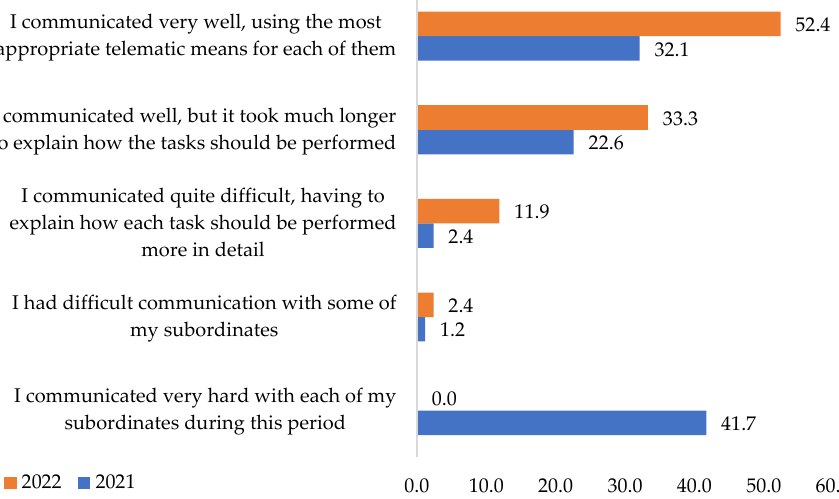
Figure 11. Communication with subordinates during the pandemic: Data from field quizzes, 2021, 2022.